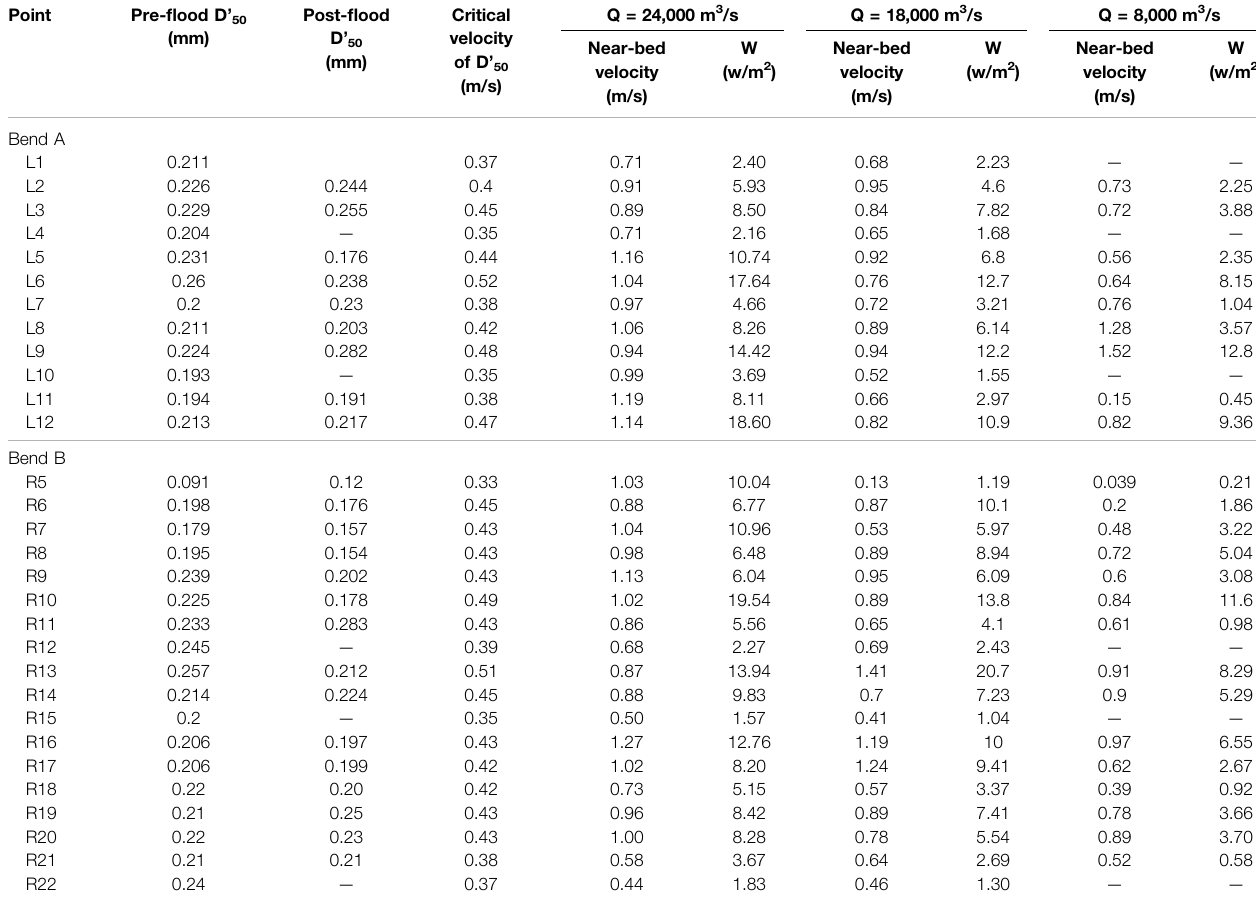
TABLE 3 | Comparison between critical velocity of bed material, near-bed velocity, and stream power at different fl ow discharges on the convex bank. Point Pre- fl ood D ’ 50 (mm)